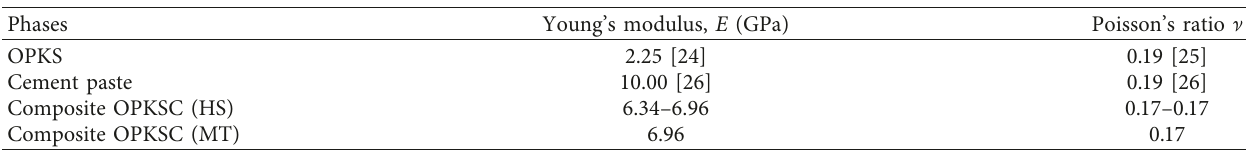
Table 8: Young’s modulus and Poisson’s ratio, obtained from the approximations of HS and MTwith r � 2.591 and v RVE of 60 × 60 × 60mm 3 .